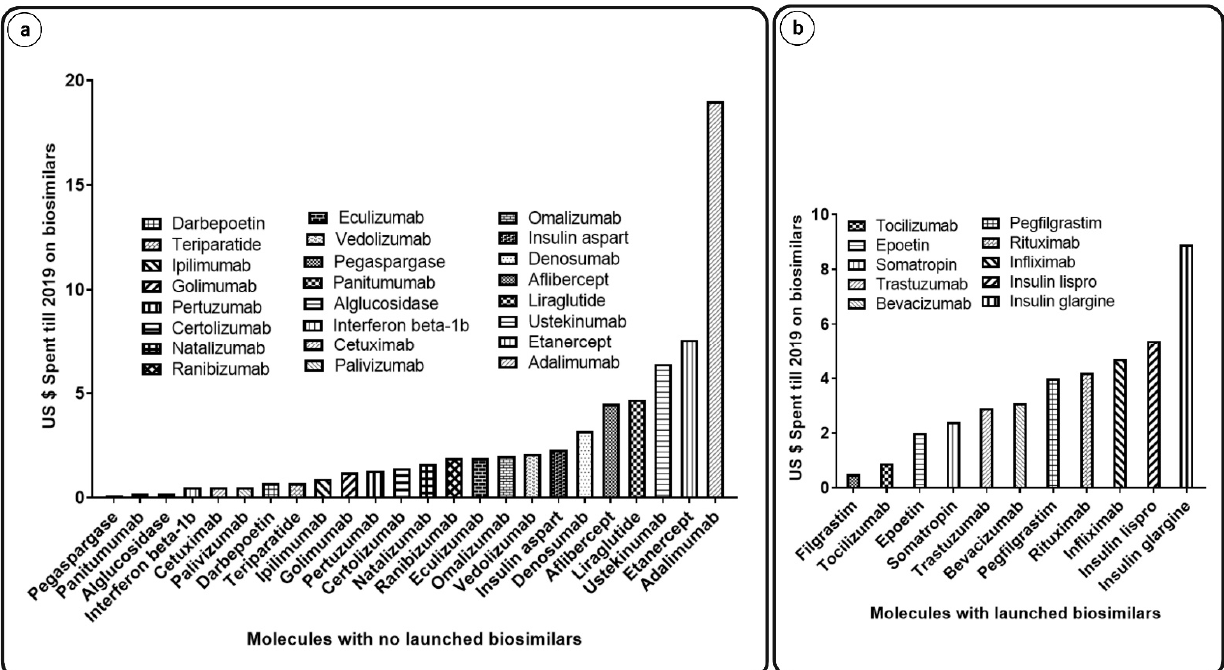
Figure 2. USD spent until 2019 on biosimilars; Graphs indicating ( a ) molecules with no launched biosimilars versus USD spent till 2019 on biosimilars and ( b ) molecules with launched biosimilars versus USD spent till 2019 on biosimilars [22].